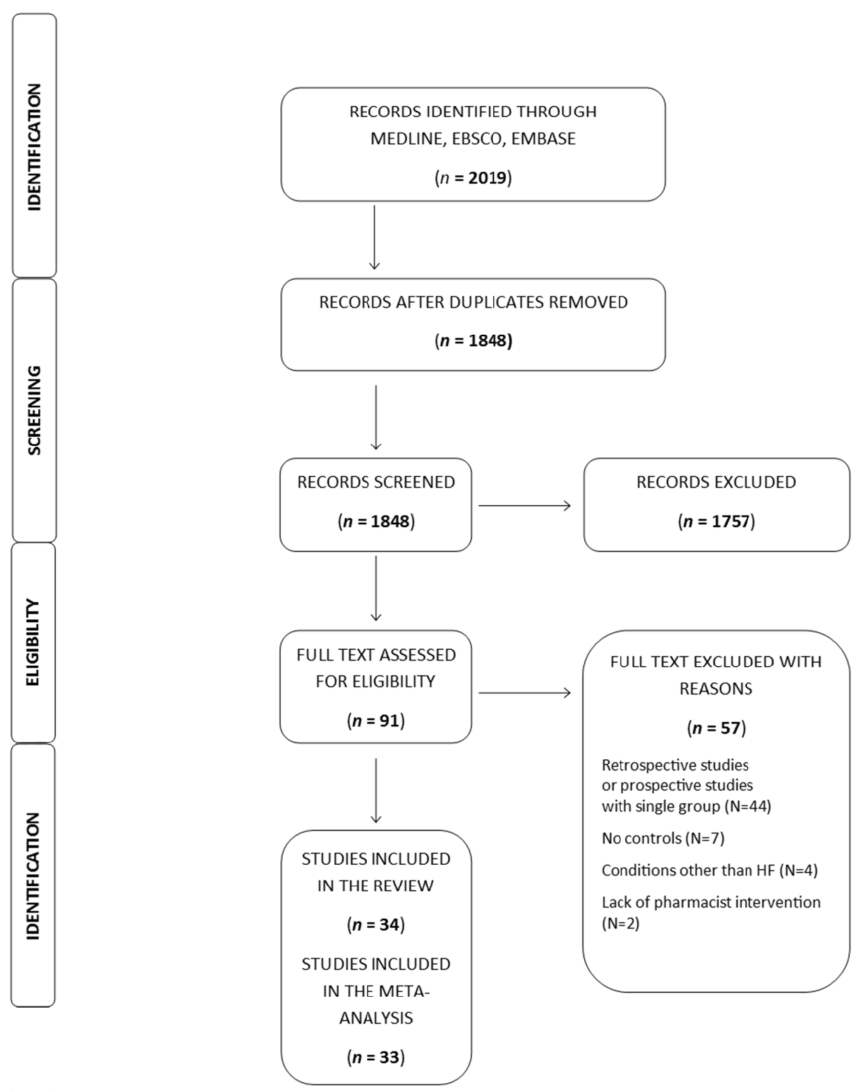
Figure 1. PRISMA flow chart of study search.